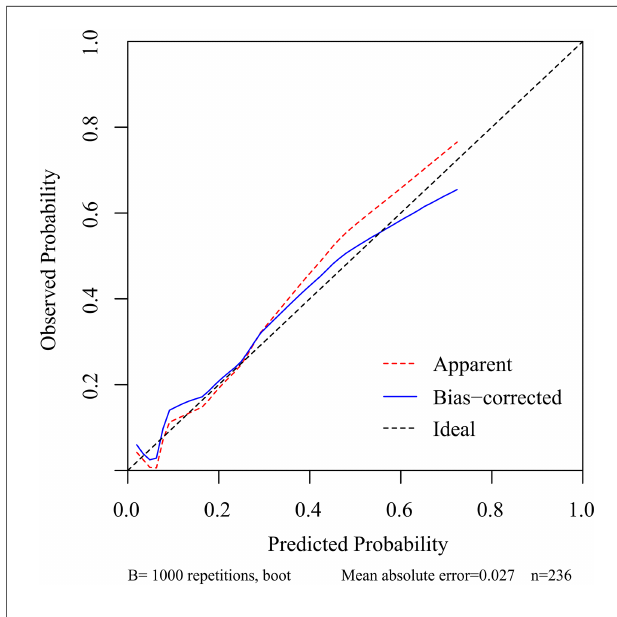
FIGURE 7 Calibration curve of the nomogram for the assessment of the consistency between the actual diagnosed residual LBP and the projected likelihood of residual